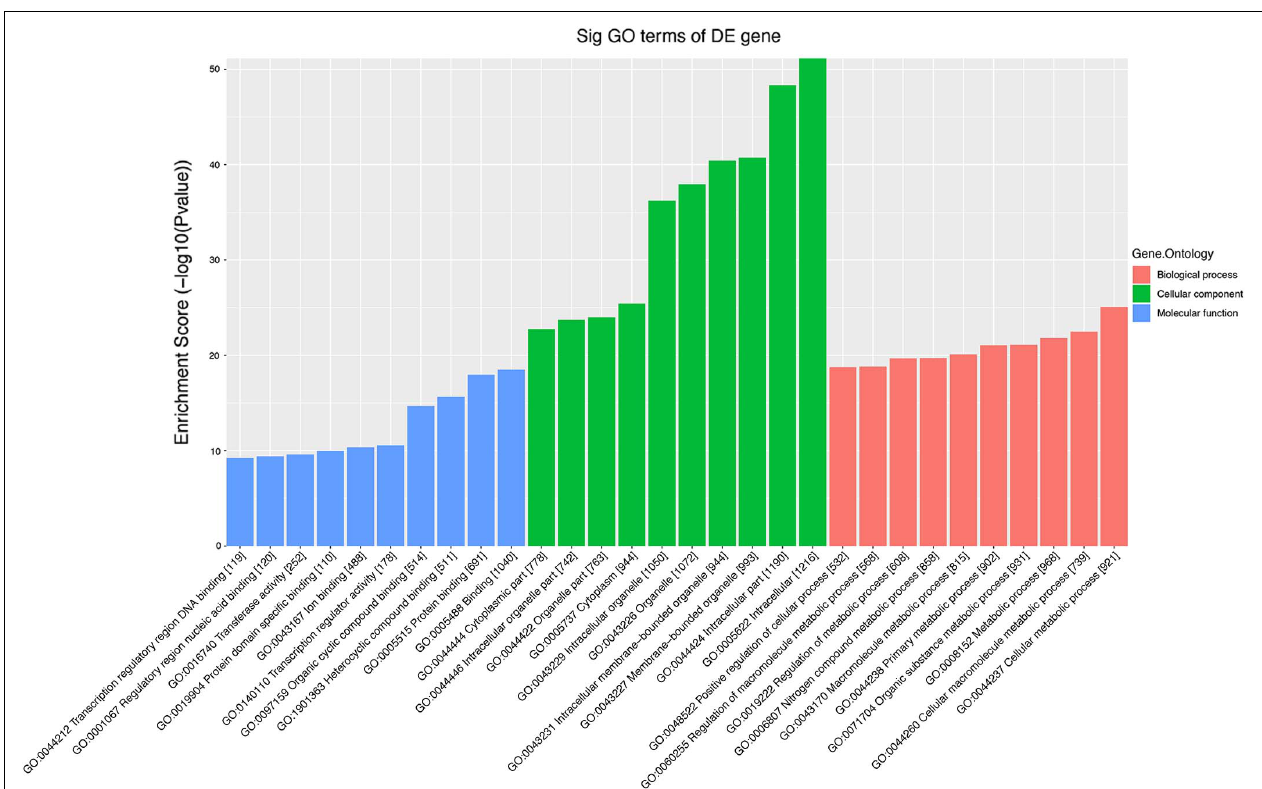
FIGURE 5 | Top 10 GO terms from BP, CC, and MF. The top 10 GO terms in each group were ranked by P -value. The top five items are cellular metabolic process, cellular macromolecule metabolic process, metabolic process, organic substance metabolic process, and primary metabolic process (from BP). Intracellular, intracellular part, membrane-bounded organelle, intracellular membrane-bounded organelle, and binding (from CC). Binding, protein binding, heterocyclic compound binding, organic cyclic compound binding, and transcription regulator activity (from MF).